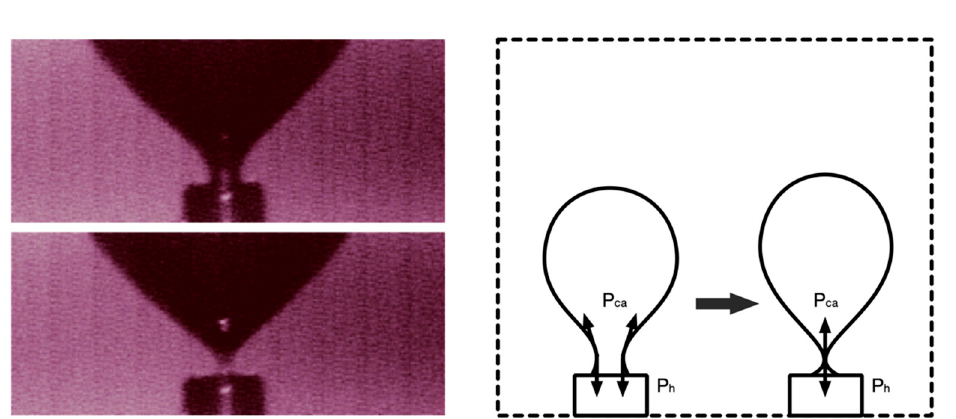
Figure 9. The process of bubble necking (photographed through the microscope lens) and schematic diagram.